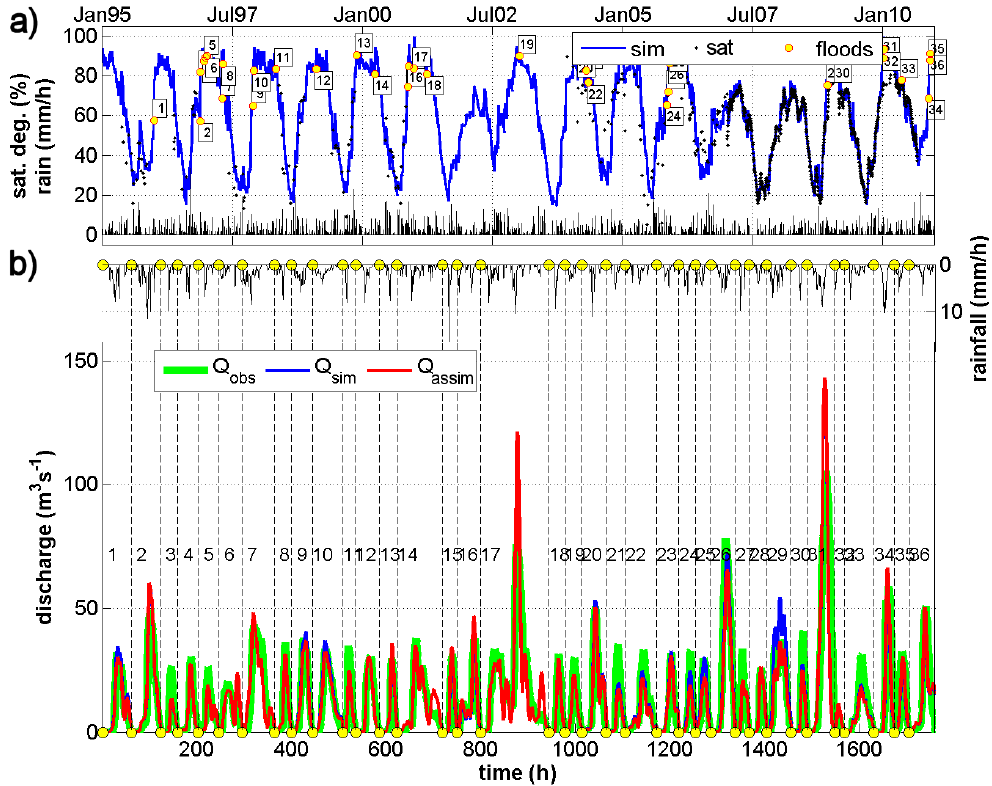
Figure 4. MISDc model results without and with the assimilation of ESA CCI soil moisture product in the Niccone river basin (central Italy). ( a ) Root zone soil moisture simulated by the model, sim, and obtained by ESA CCI soil moisture product, sat, for the period 1995–2010. The filled circles, floods, represent the initial conditions of the selected flood events simulated by MISDc model and identified by the numbers in the lower panel; ( b ) Observed, Q obs , versus simulated, Q sim , and simulated with assimilation, Q assim , discharge for the sequence of the flood events occurred in the study period. The corresponding hourly rainfall is also shown in both panels (note that time axis is different in the upper and lower panel).